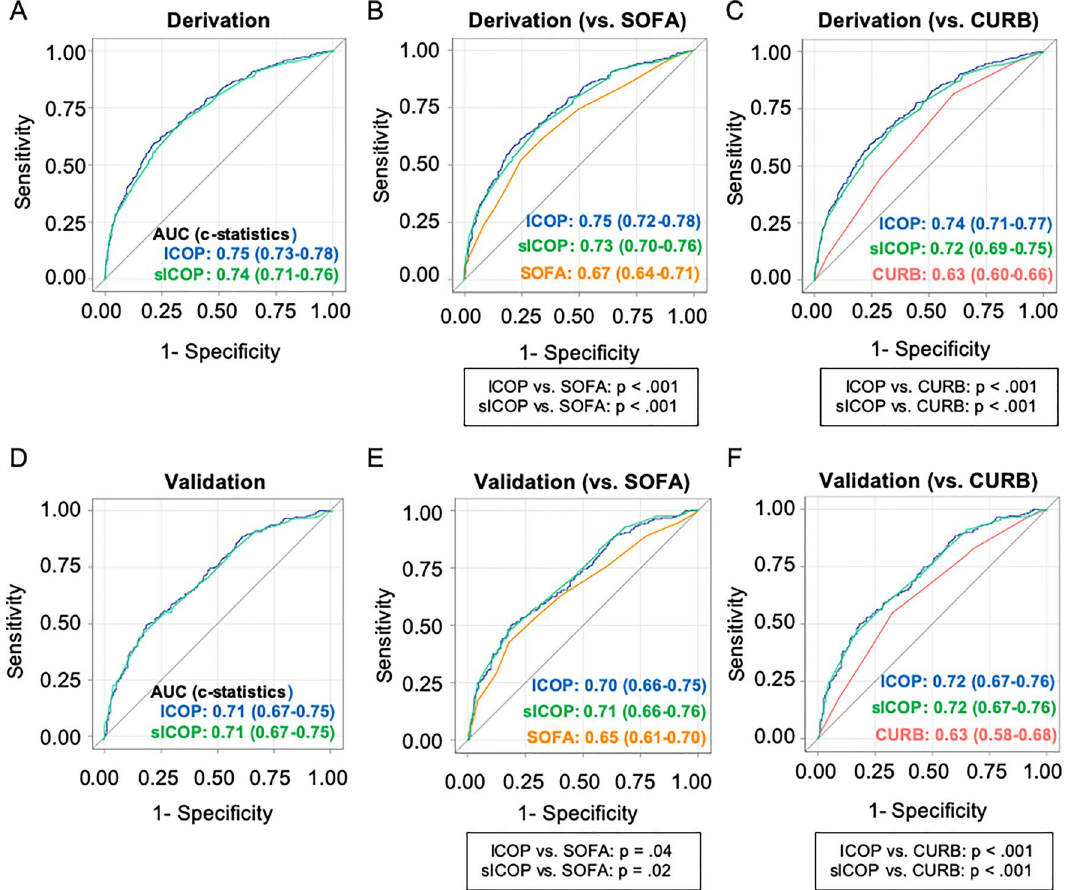
Figure 3. Receiver operating characteristic curves for 14-day mortality after intubation. The Receiver Operating Characteristic (ROC) Curves of our predictive score (ICOP score) and simplified version of the score (sICOP) for 14-day mortality after intubation in derivation ( A ) and validation cohorts ( D ). The c -statistics of ICOP score and sICOP were compared with SOFA score ( B , E ) and CURB-65 score ( C , F ) by DeLong’s test. In the comparison with SOFA score or CURB-65 score, only patients in whom all variables needed for the calculation of the corresponding scores were available, were analyzed (n = 1046 in derivation and n = 446 in validation cohorts for SOFA score, and n = 1158 in derivation and n = 514 in validation cohorts for CURB-65 score). AUC , area under the receiver operating characteristic curve; SOFA , sequential organ failure assessment score (SOFA score); CURB , CURB-65